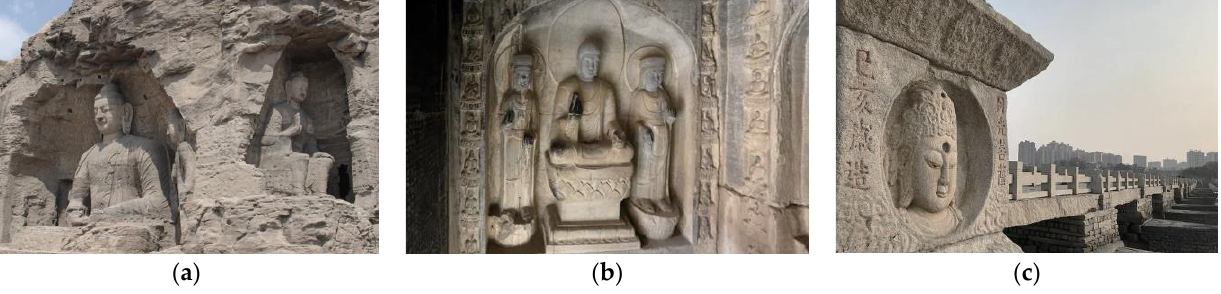
Figure 3. Representative heritage sites of the three types of stone in China ( a ) Yungang Grottoes, ( b ) Lingquan Temple Grottoes, ( c ) Luoyang